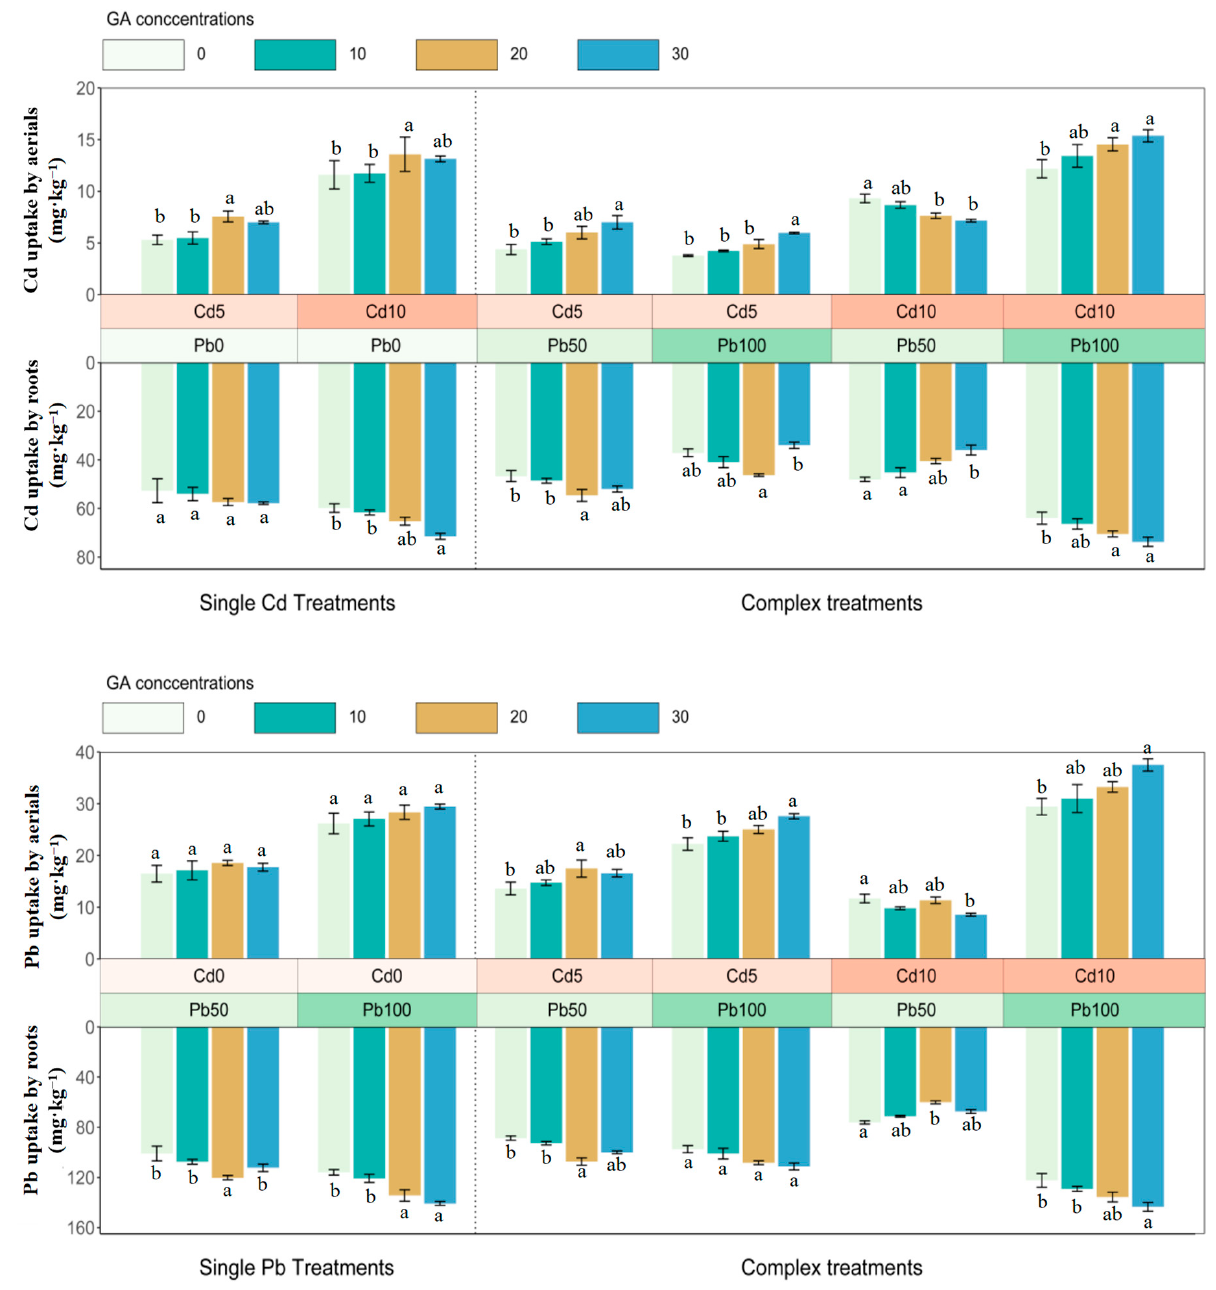
Figure 3. Cd and Pb accumulation in aerials and roots of sunflower in GA treatments after 45 days. GA, glutaric acid. Bars with different letters indicate significant difference at p < 0.05. Error bars represent ± SE.